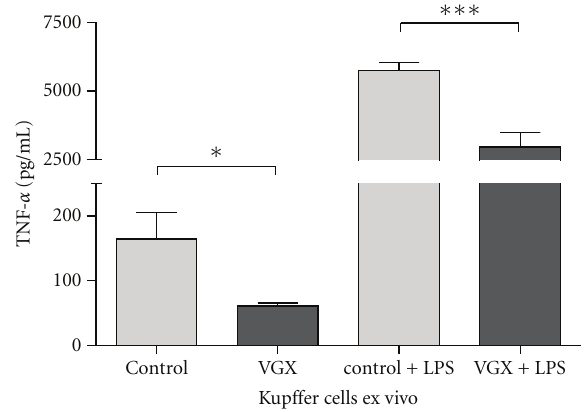
Figure 6: The vagus nerve has a stimulating e ff ect on kup ff er cells. Kup ff er cells were isolated from control mice (column “control”) and from vagotomised mice without sepsis (column “VGX”). The basal TNF release of kup ff er cells ex vivo is significantly decreased if mice were vagotomised 7 days before cell isolation (164 . 7 ± 40 . 9pg/mL versus 61 . 1 ± 4 . 4pg/mL, ∗ P = 0 . 04). In addition, we stimulated the cells ex vivo with 1 μ g/mL lipopolysaccharide from E.coli (LPS). In the septic organism, there is a significantly decreased TNF- α release by stimulated kup ff er cells from vagotomised mice (2960 ± 513.1 pg/mL) when compared to mice with an intact nervus vagus (5746 ± 292 . 5 pg/mL, ∗∗∗ P = 0 . 0002, n = 10 per